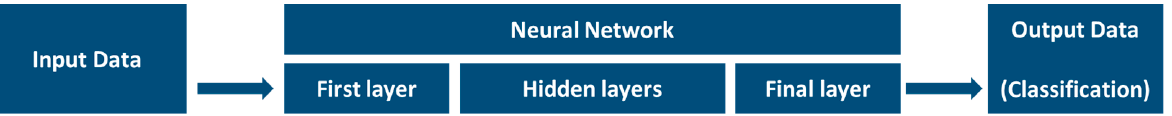
Figure 3. Description of a neural network model.